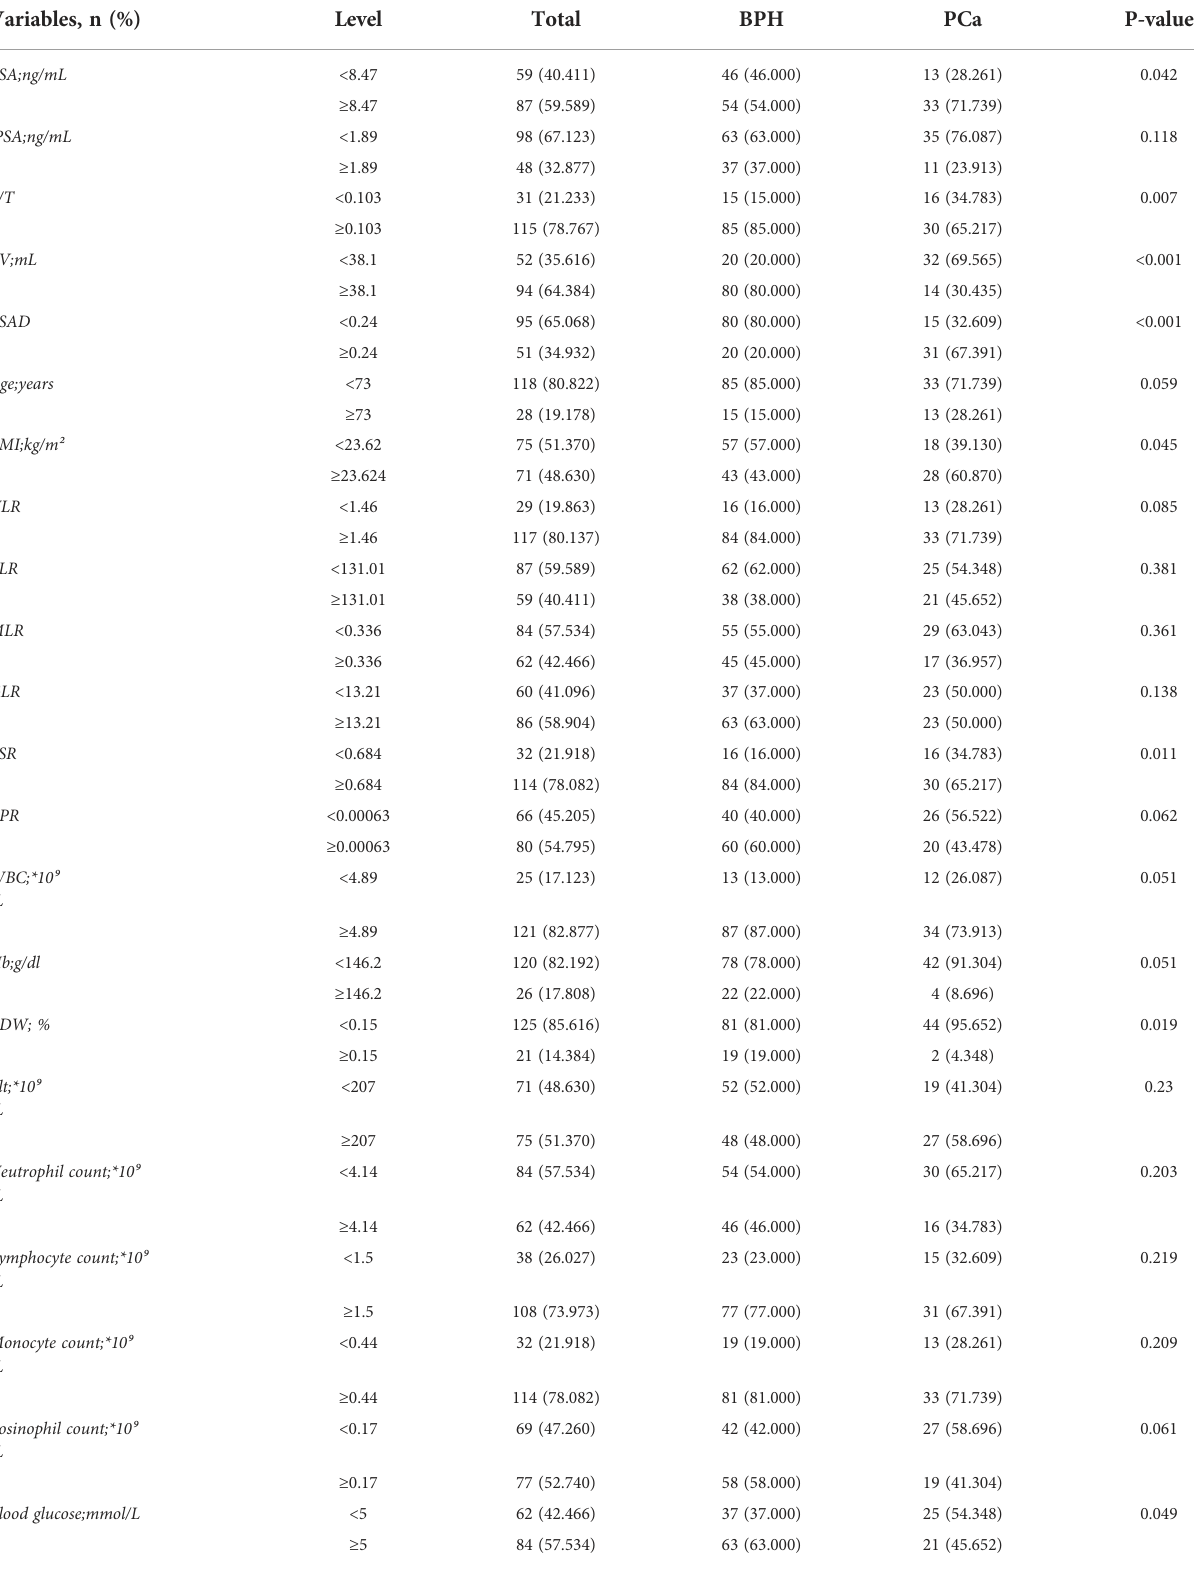
TABLE 1 Clinical characteristics of patients in the training